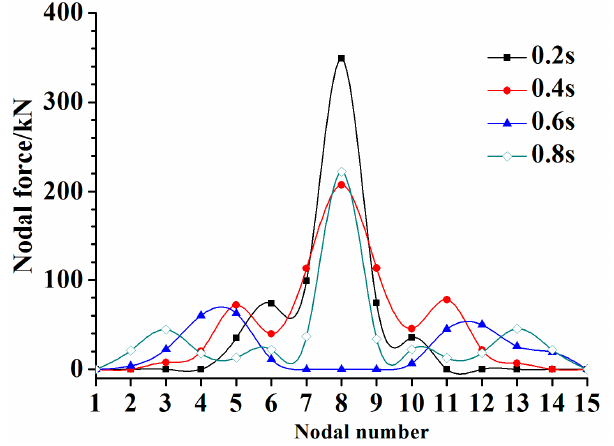
Figure 10. Nodal force at different times.